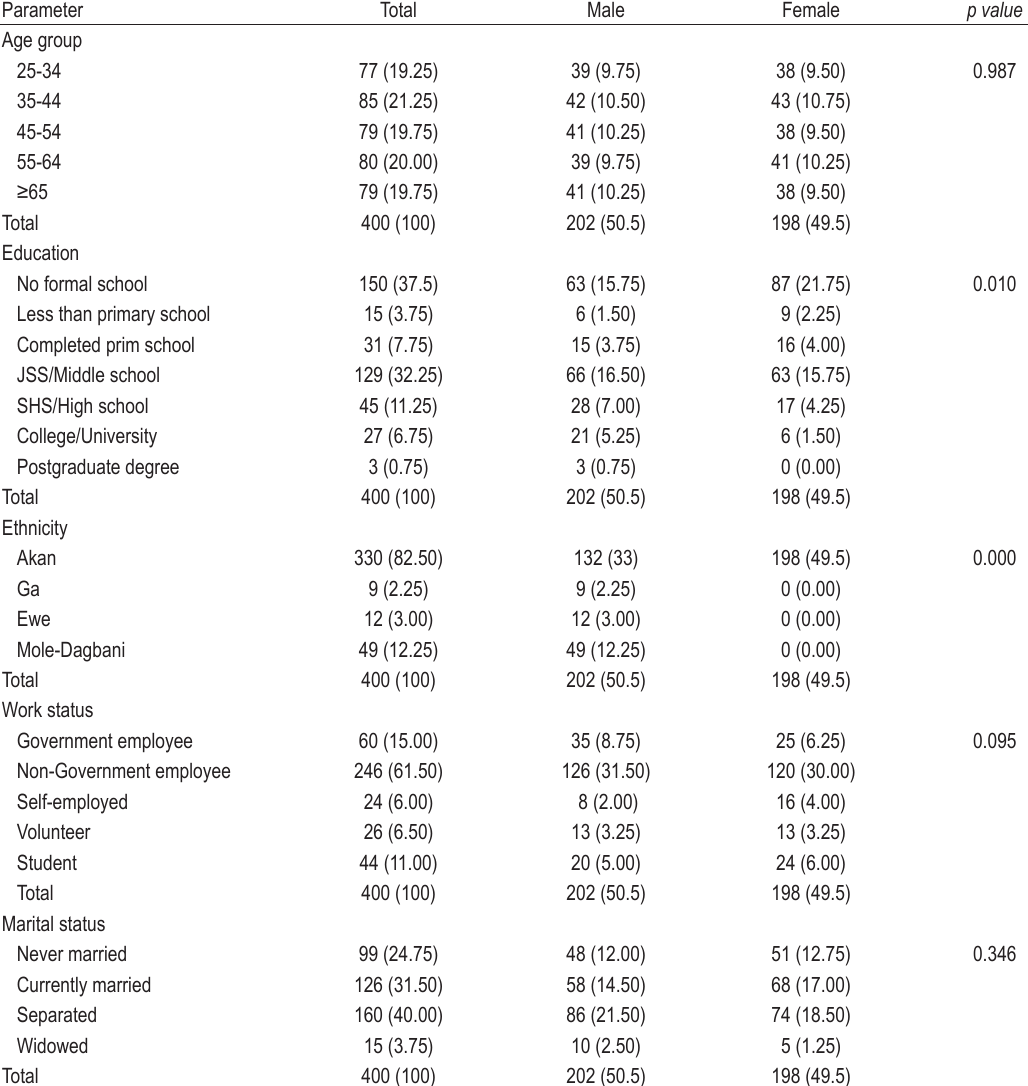
TABLE 1. Sociodemographic characteristics of the study population stratified by gender n (%) Parameter